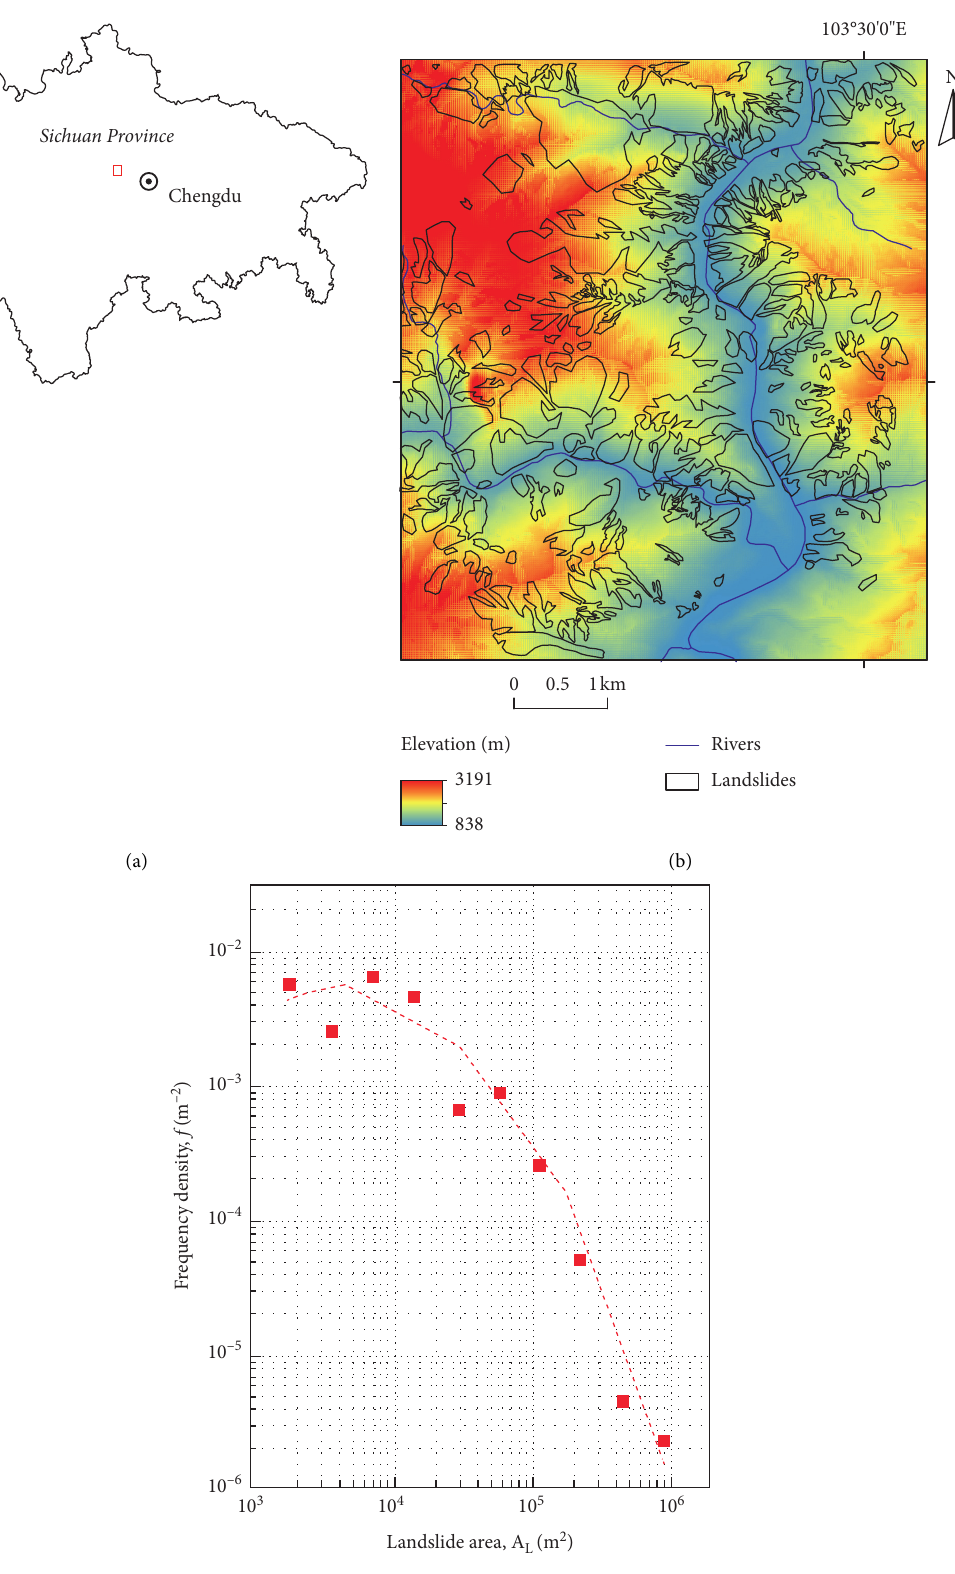
Figure 1: Geographic location of the study area and the coseismic landslides triggered by the 2008 Wenchuan earthquake. (a) Location of study area. (b) Shaded elevation map showing coseismic landslides in the study area. (c) Landslide area versus frequency density in the study